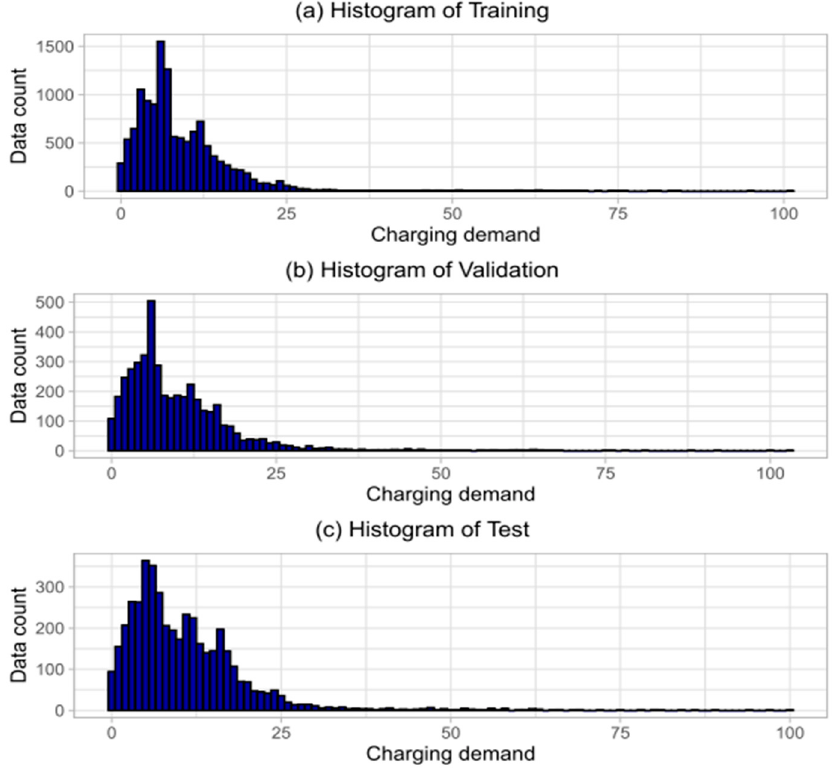
Figure 6. Histograms of ( a ) Training, ( b ) Validation, and ( c ) Test sets, in 1 kWh increments. Table 3. Statistics of Training, Validation, and Test Sets, in kWh.